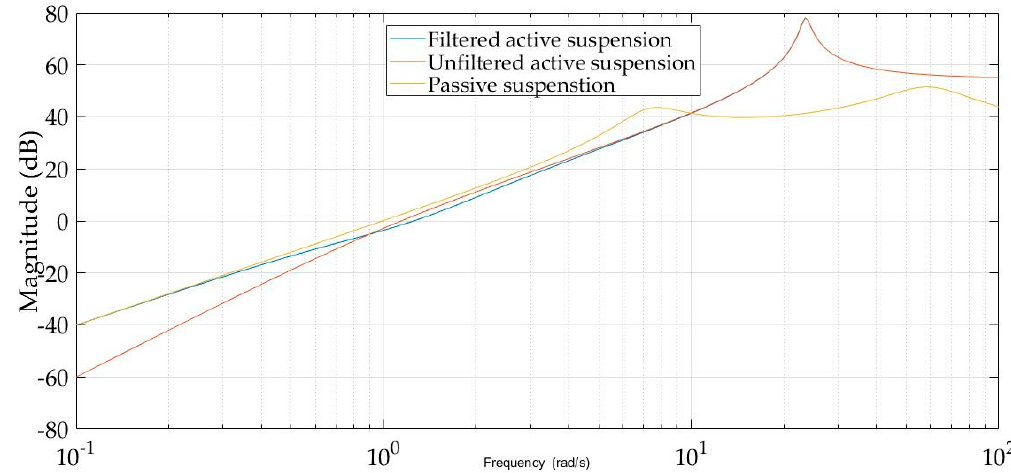
Figure 12. Sprung mass acceleration against the road frequency for both filtered and unfiltered active suspension systems of Case 2.